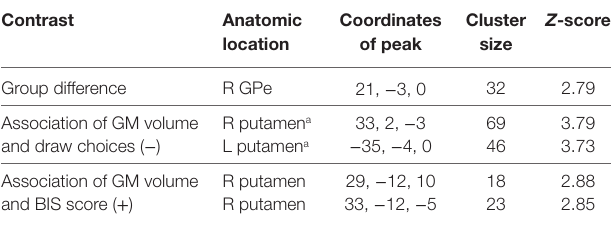
Table 4 | Regions of interest (ROIs) that show differences in GM volume between the impulse control disorder (ICD) + and ICD − groups, and ROIs showing associations between GM volume and behavioral measures [i.e., number of draw choices in the beads task and scores on the Barratt Impulsiveness Scale (BIS)